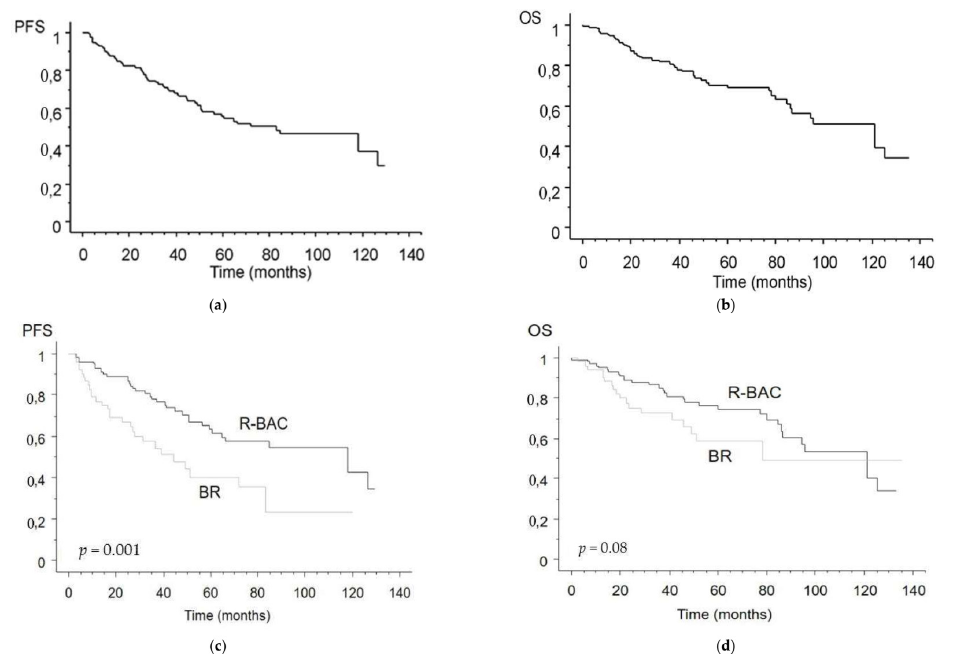
Figure 1. PFS ( a ) and OS ( b ) of all 156 MCL patients. PFS ( c ) and OS ( d ) of all 156 MCL patients divided according to administered upfront treatment. divided according to administered upfront